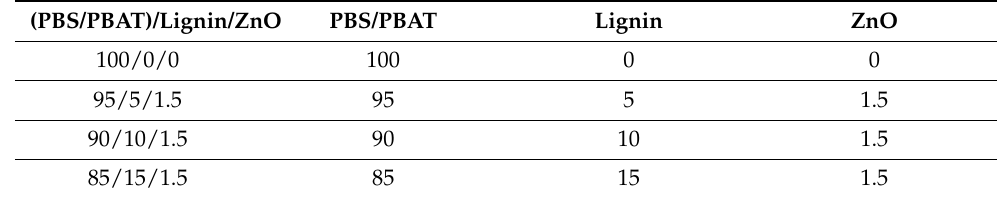
Table 2. Different formulations of the